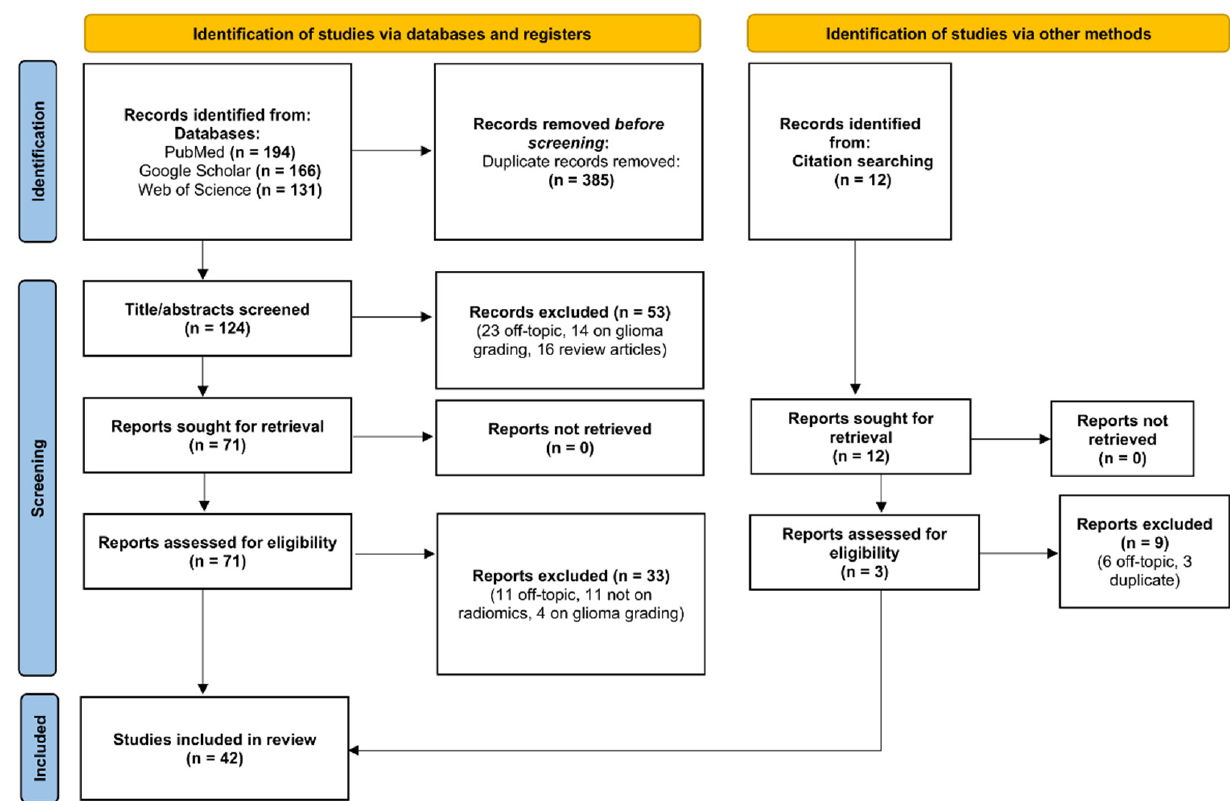
Figure 1. Preferred Reporting Items for Systematic Reviews and Meta-Analyses (PRISMA) flow diagram of included studies.